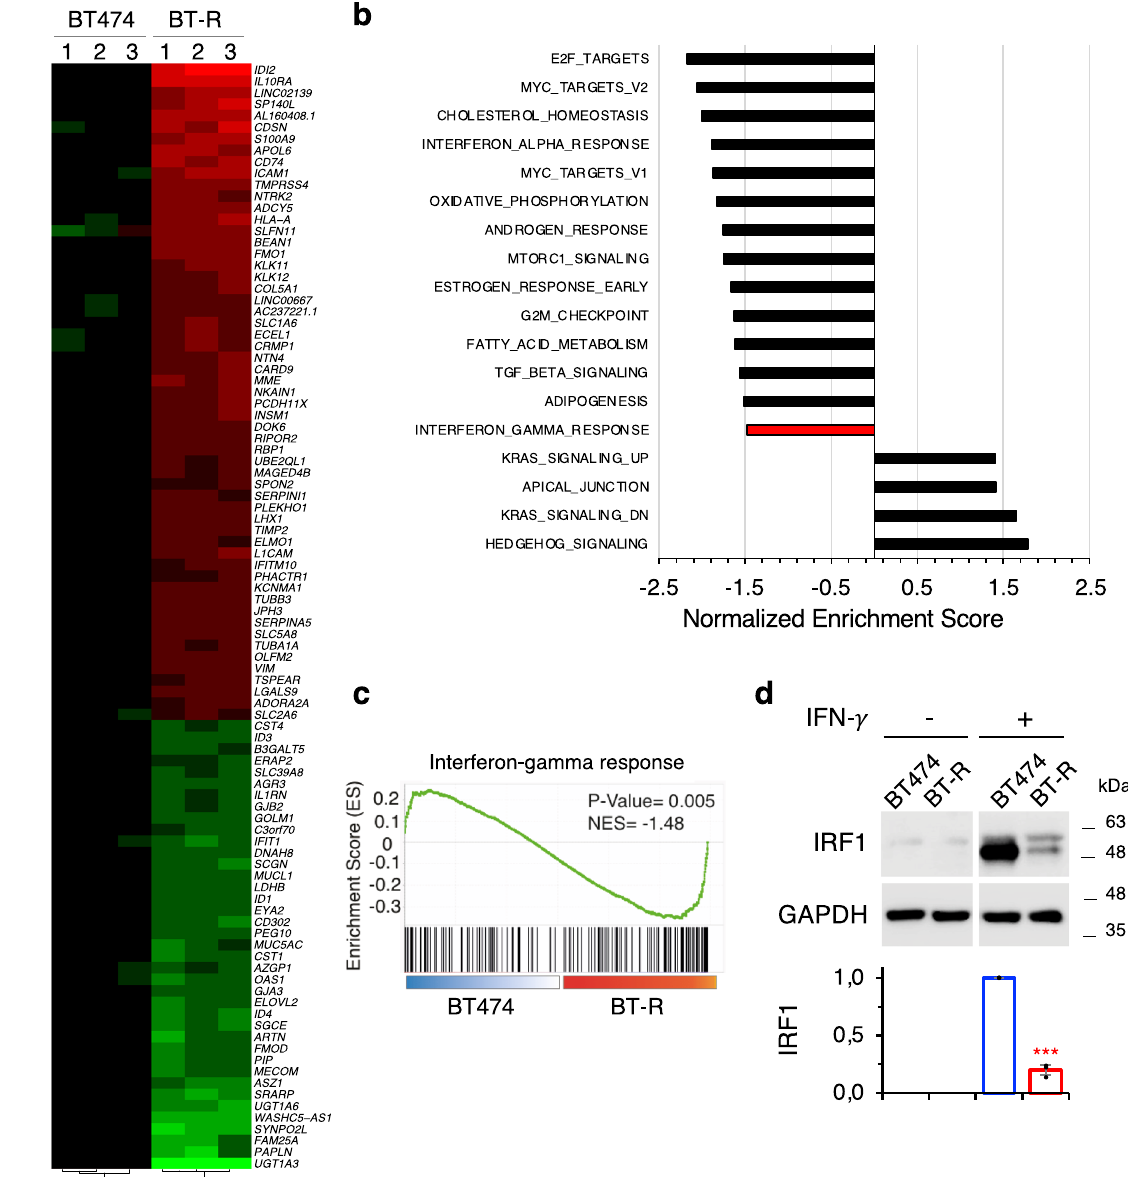
Fig. 2 Transcriptomic analysis. a Heatmap showing the 97 most differentially expressed genes in BT-R cells compared to parental BT474 cells ( ≥ 4-fold; p < 10 − 5 ). p Value was obtained from the DESeq2 analysis of the RNA-seq. Genes with FDR < 5% and |shrunken fold change| > 1.5 were considered signi fi cant. b Pathways showing positive and negative enrichment in BT-R compared with BT474 cells as determined by GSEA. Only statistical gene sets are shown (NOM p value < 0.05). c IFN- γ response GSEA signature in resistant cells, compared to parental BT474. p Value corresponds to the NOM p value obtained by GSEA in the HALLMARK database. d Levels of IRF1 upon treatment with IFN- γ in BT474 and BT-R cells were determined by Western blot analysis. Results of three independent quanti fi cations, normalized to treated BT474 cells, are presented as mean ± SD. *** p < 0.001, two-tailed t test. Source data are provided as a Source Data fi